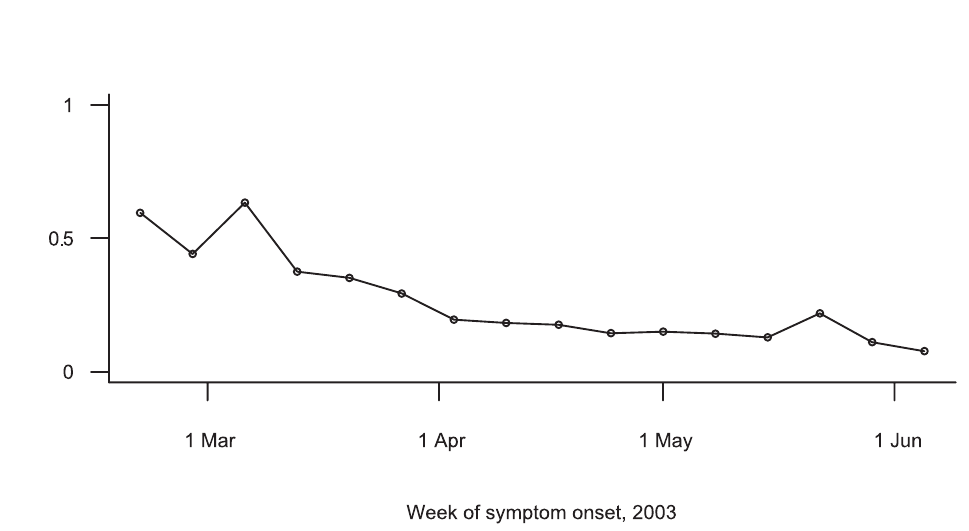
Figure 3. Proportion of Infectious Period Spent in the Community before Hospitalization as a Function of Week of Symptom Onset. doi:10.1371/journal.pcbi.1000471.g003 PLoS Computational Biology |